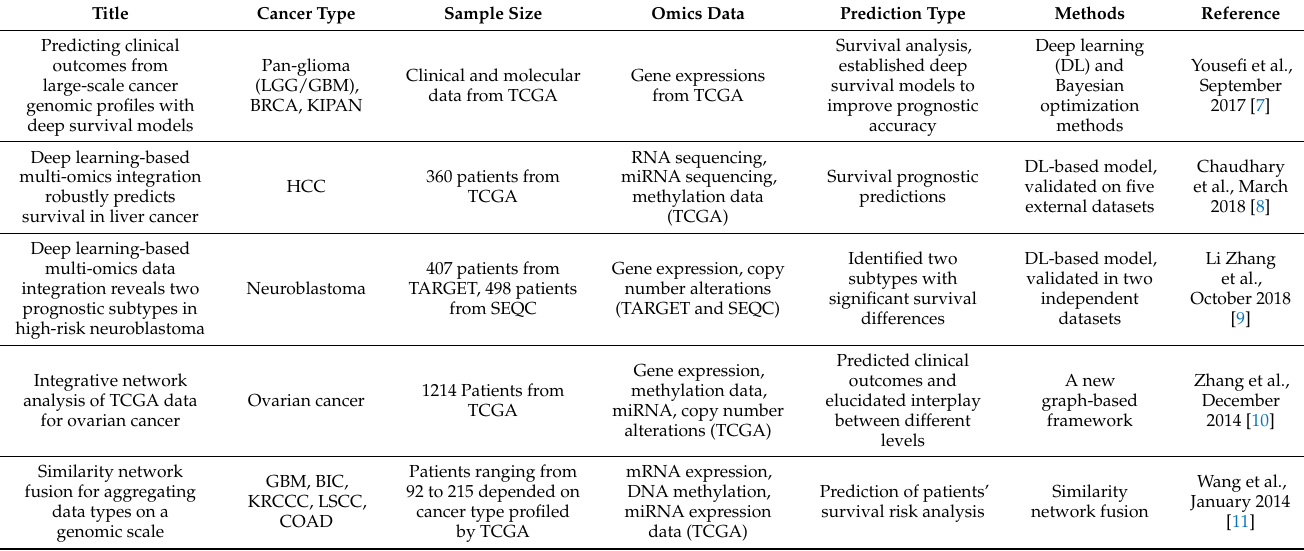
Table 1. Comparisons of studies integrating omics data for prognostic